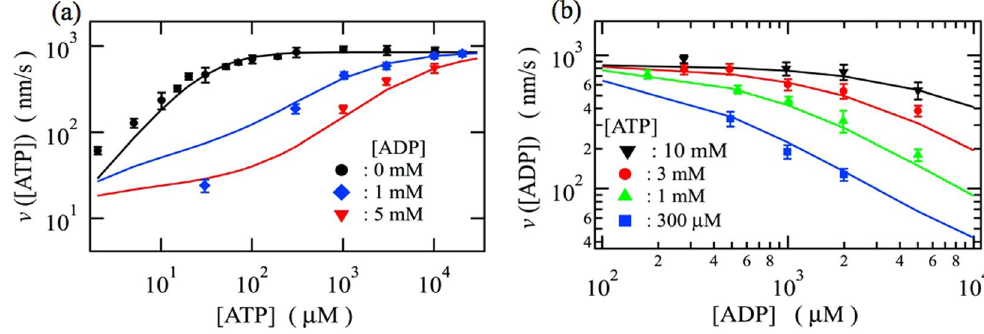
Figure 4. ( a ) ATP-concentration dependences of the motor velocity at several ADP concentrations. ( b ) ADP-concentration dependences of the motor velocity at several ATP concentrations. The lines indicate the theoretical results and the symbols indicate the experimental data obtained from the literature 23